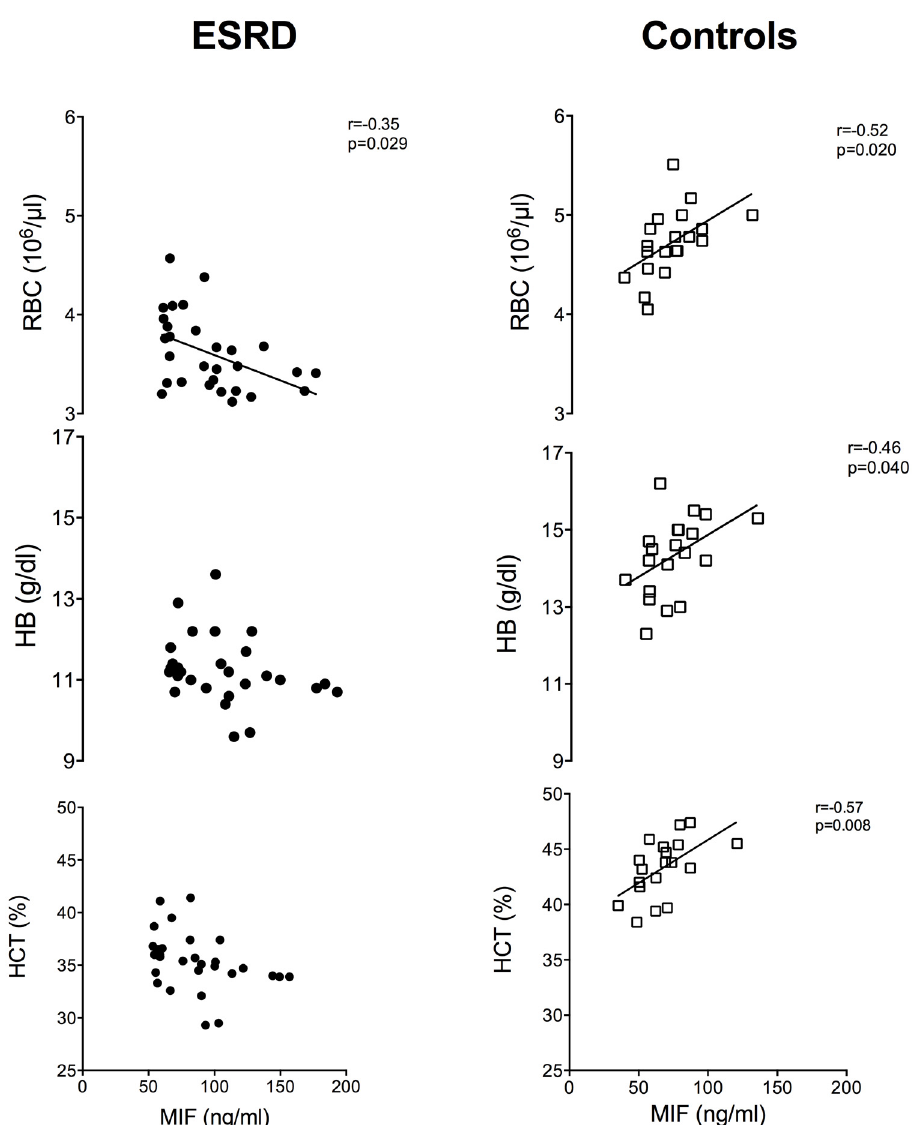
Fig 4. Platelets are associated with MIF plasma levels in ESRD patients but not in healthy controls. A ) Platelets count does not differ between ESRD patients and healthy controls. B ) Platelets count correlates with MIF plasma levels in ESRD patients (p < 0.02). C ) Healthy subjects show no correlation between platelets and circulating MIF levels (p =